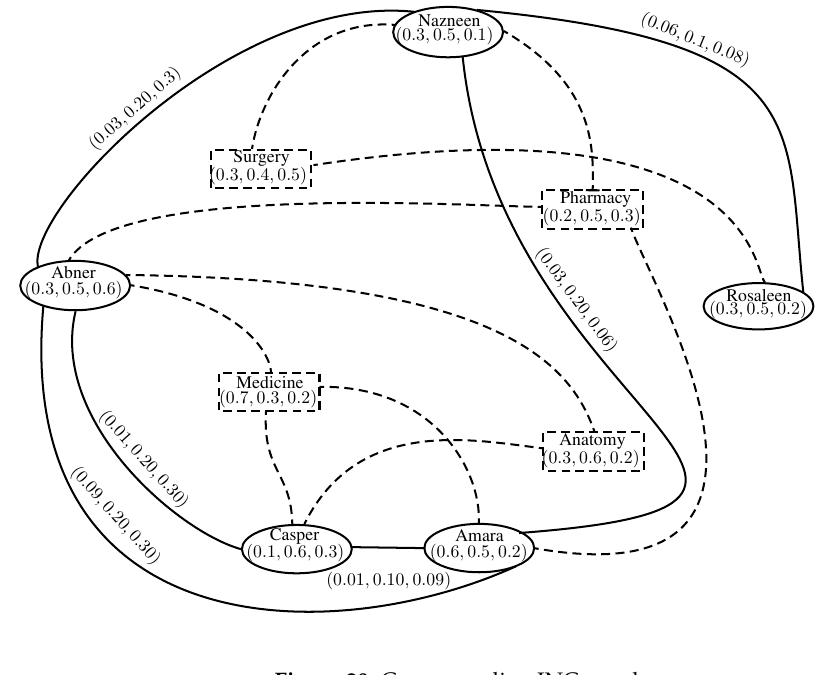
Figure 20. Corresponding INC-graph. Table 10. Strength of competition of the applicant for a particular